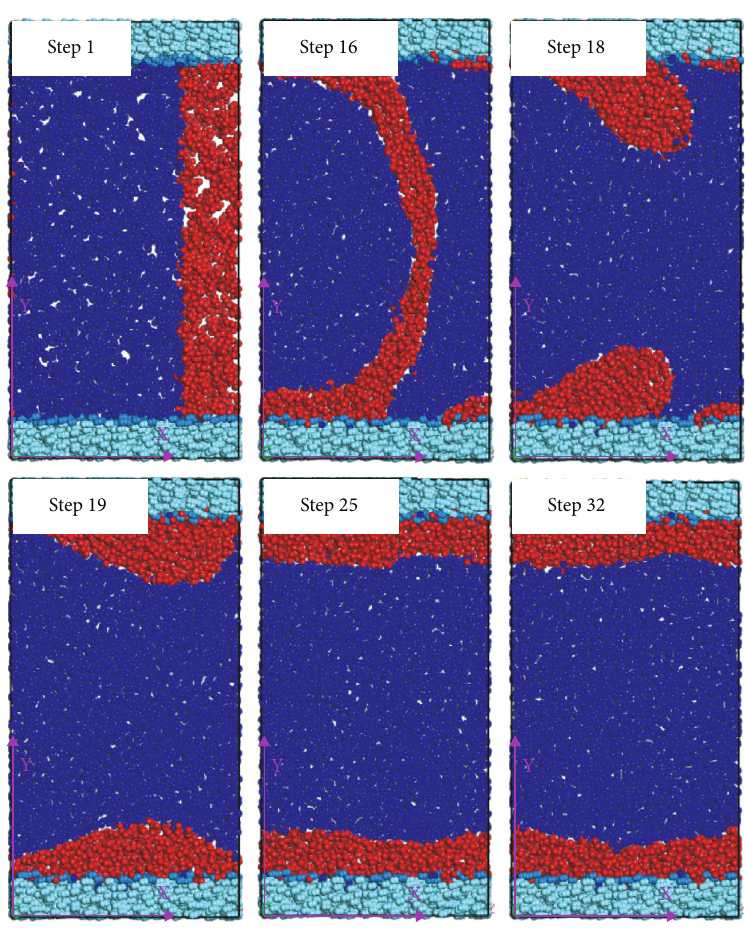
Figure 12: Section of the slits of model 11.